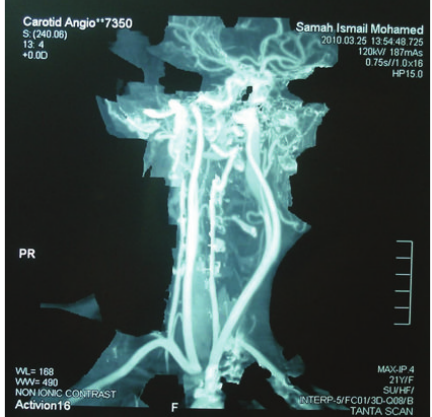
Figure 2: Coronal view of CT angiography showing left parapha- ryngeal and pharyngeal mainly hypodense, peripherally hyperdense well-defined lesion (7 × 4 × 3 cm) indenting the left pharyngeal wall but not infiltrating it.